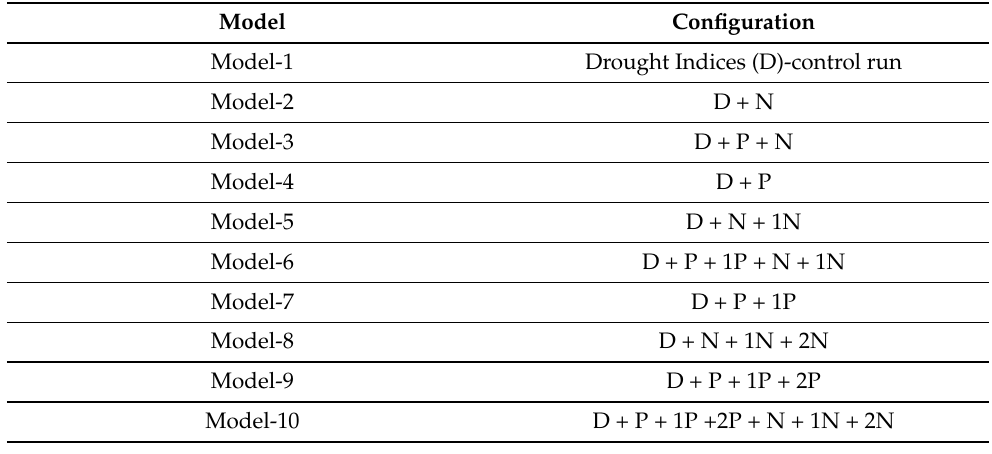
Table 3. Different combinations of Twitter data when added as individual features to the control run ‘D’. ‘P’ represents the count of positive tweets. ‘N’ represents the count of negative tweets. ‘xN’ & ‘xP’ represent the count of negative and positive tweets ‘x’ week before, respectively.